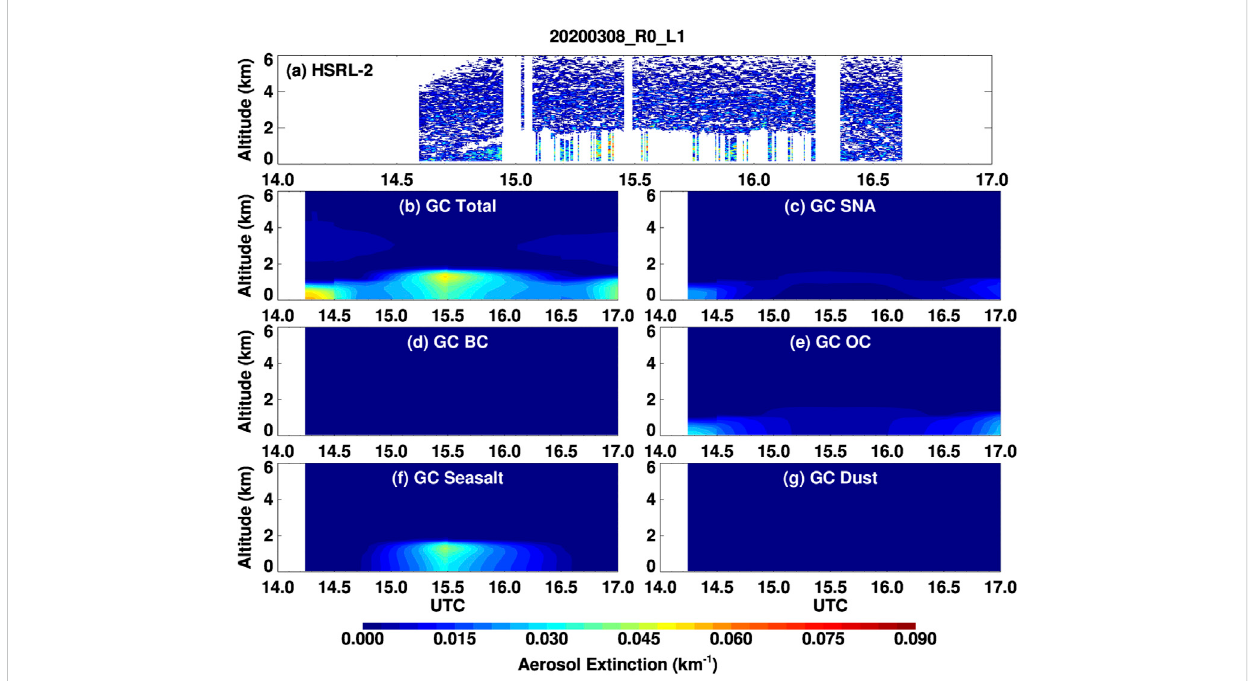
FIGURE 2 (A) Aerosol extinction derived from HSRL-2 measurements (532 nm) and (B) GEOS-Chem simulations (550 nm) of aerosol extinction during the 8 March 2020 morning fl ight. Aerosol extinction below and within clouds is not shown in the HSRL-2 results. Also shown are GEOS-Chem simulated contributions to aerosol extinction made by (C) sulfate + nitrate + ammonium, (D) black carbon, (E) organic carbon, (F) sea salt, and (G) dust. All panels share the same color bar. Note the large contribution to the GEOS-Chem aerosol extinction made by sea salt.